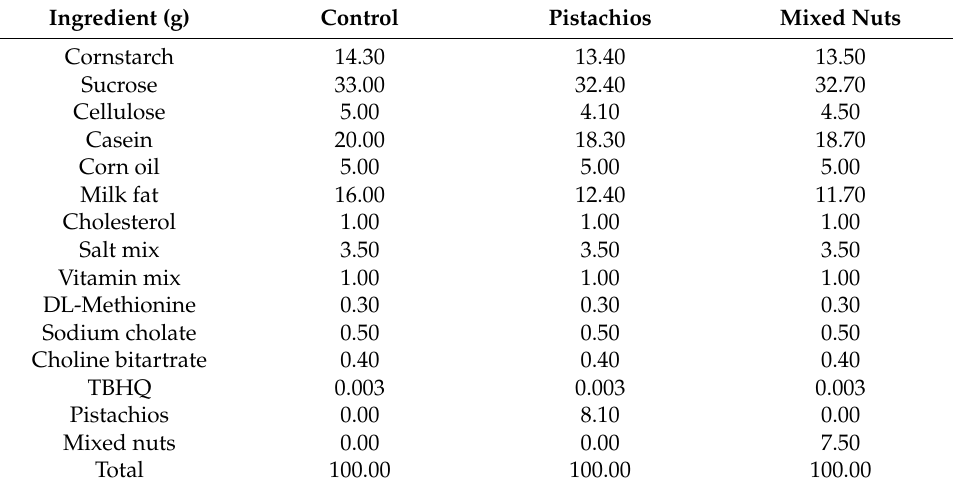
Table 3. Composition of experimental